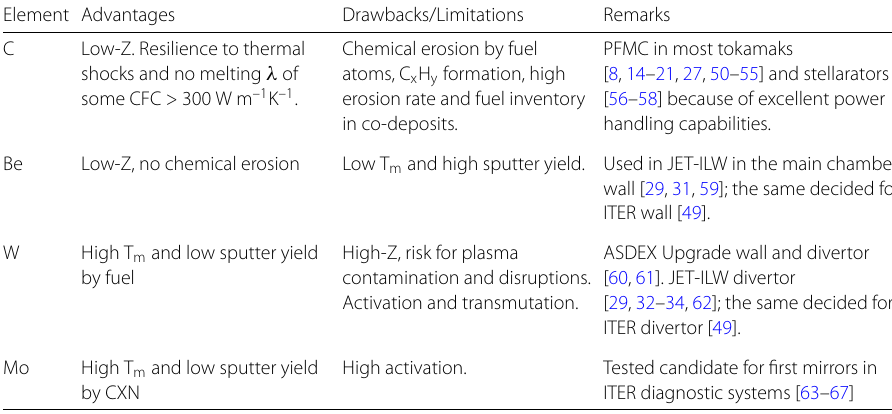
Table 1 Key properties of C and metals as wall materials and diagnostic